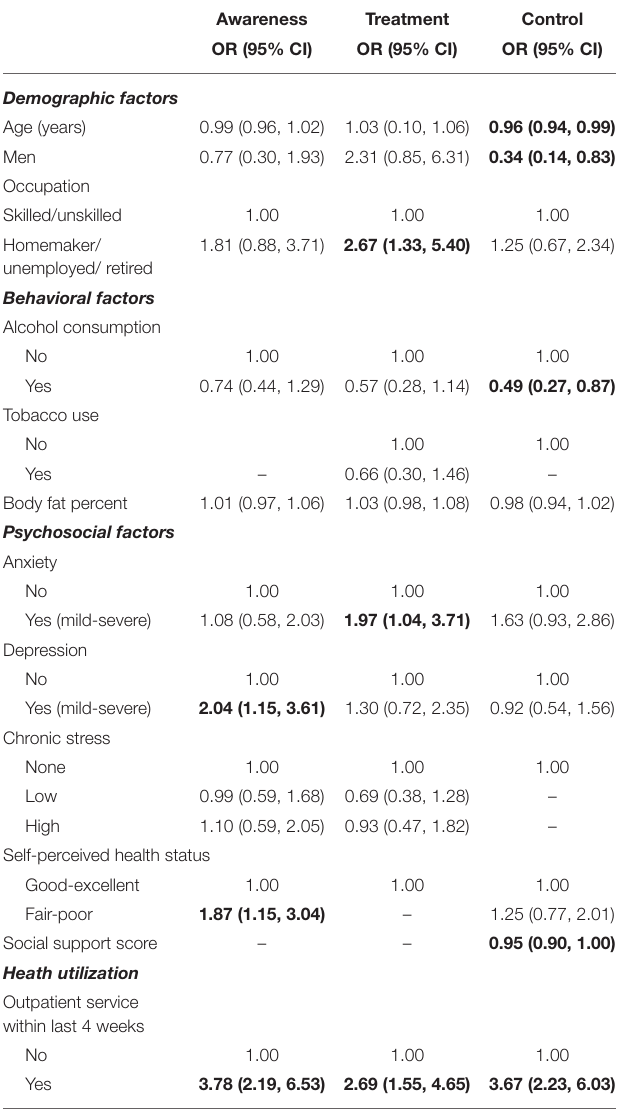
a Results obtained from multi-level mixed logistic regression model, considering (cluster as level 2) among hypertensive participants at baseline. Bold values indicate statistically significant at p < 0.05. Variables selected in each model was based on the results of univariate analyses, some